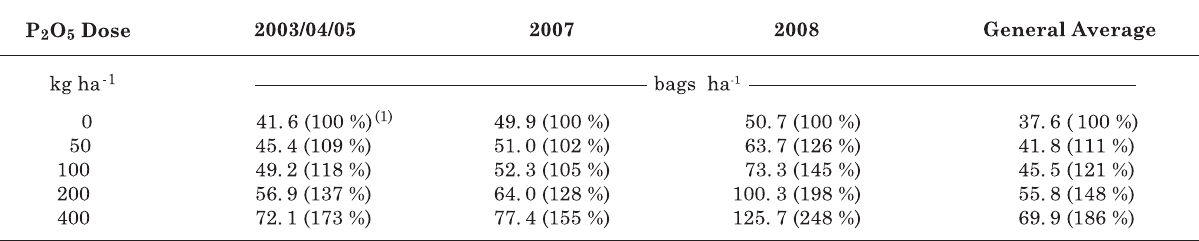
(1) Numbers in brackets refer to the yield percentage compared to the control (rate 0 = 100 %). * As the trees were pruned in 2005, there was no production in 2006. However, this year was also considered in the overall average; ** Data for this experiment cited from Guerra et al.